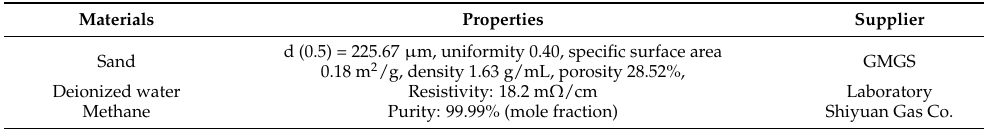
Figure 2. Particle size distribution of the sand. Table 1. Material properties.